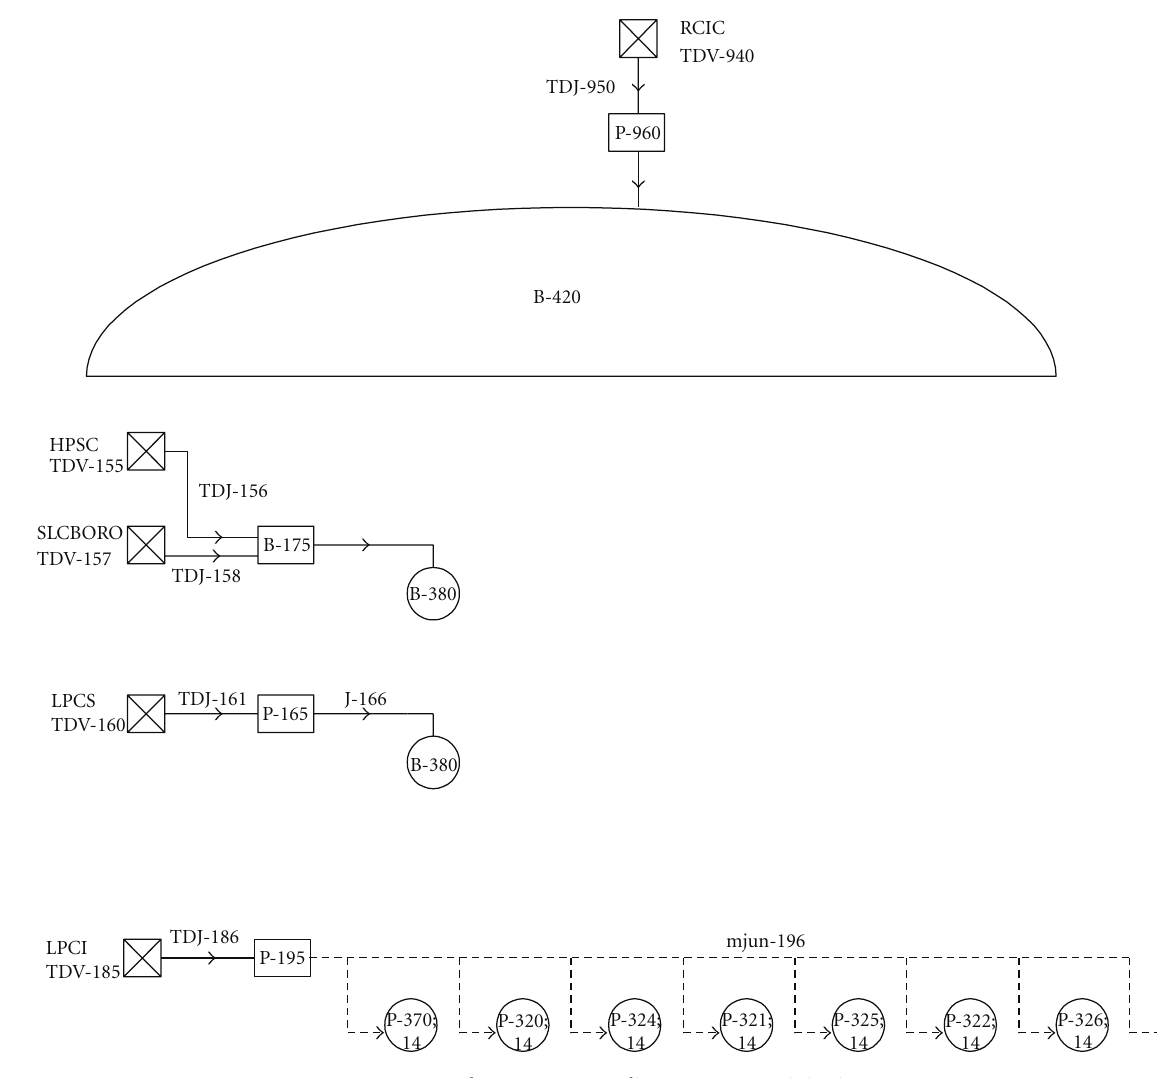
Figure 7: Laguna Verde: emergency cooling system water injection components. Table 1: Timing of major damage progression events for a scenario with depressurization and termination of emergency water injection at 4.2 hours after reactor scram (CRD flows